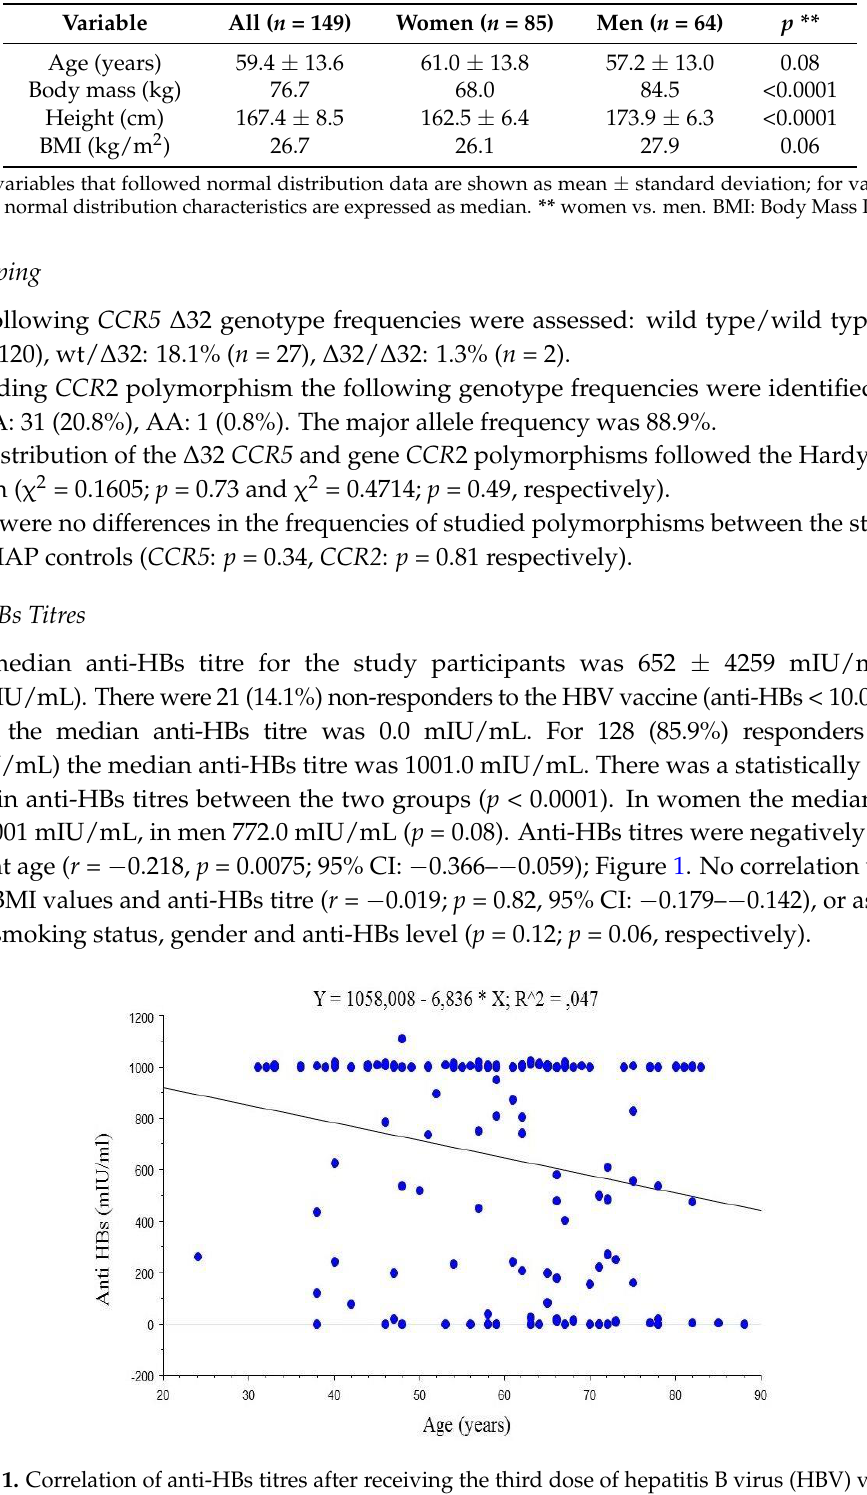
Figure 1. Correlation of anti-HBs titres after receiving the third dose of hepatitis B virus (HBV) vaccine with patient age ( n = 149).